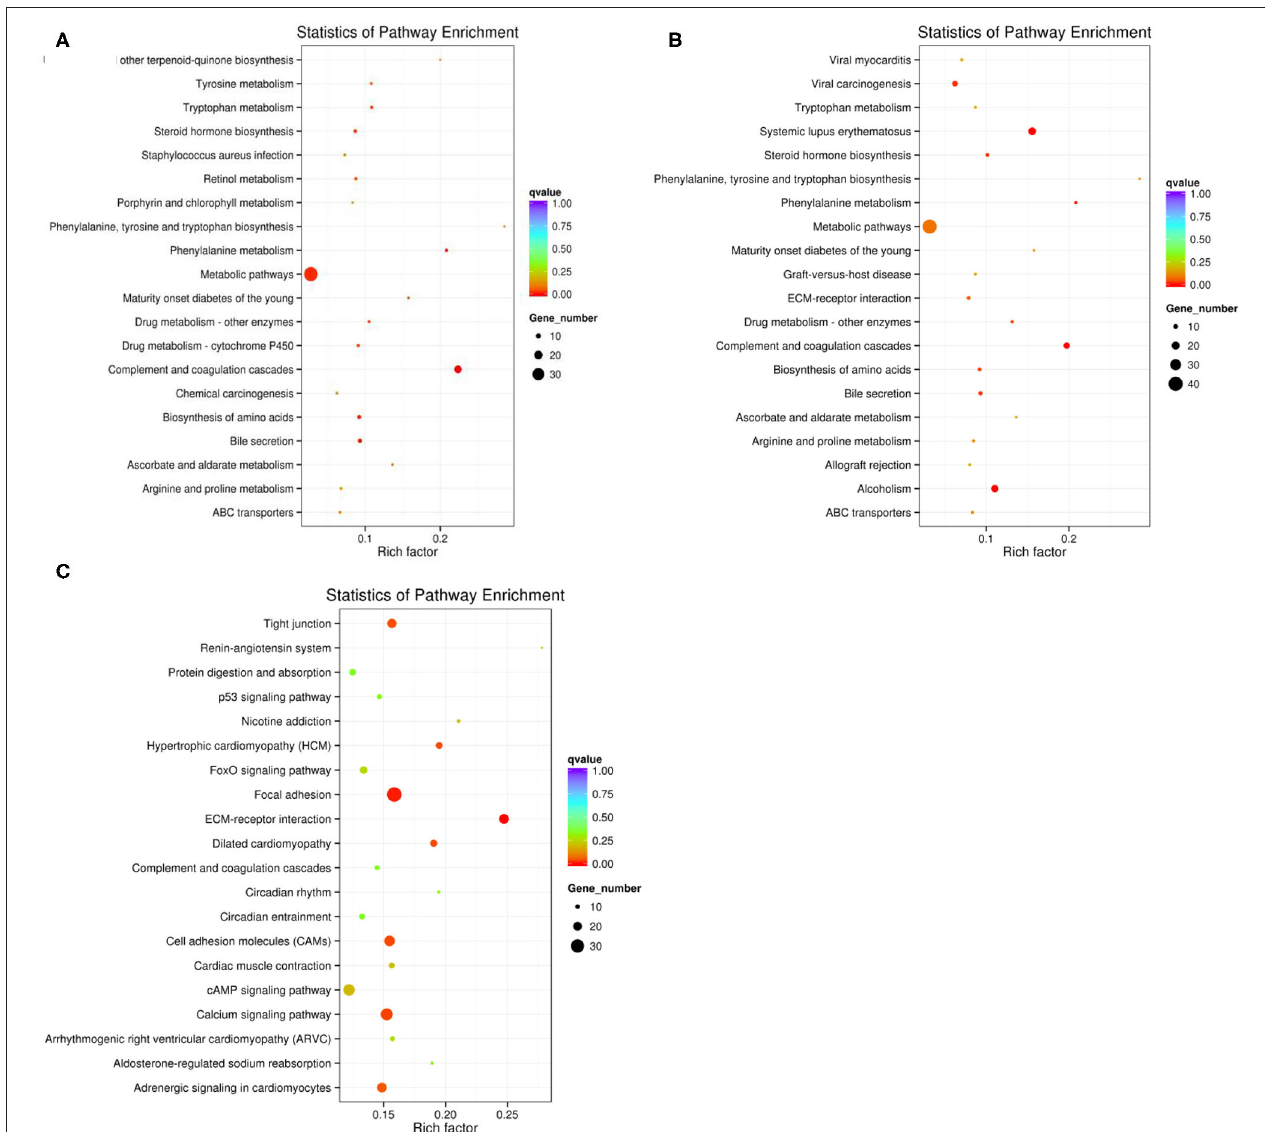
FIGURE 2 | (A) The top KEGG enrichment analyses of the differentially expressed mRNAs in M70 vs. M90. (B) in M70 vs. M120. (C) in M120 vs.